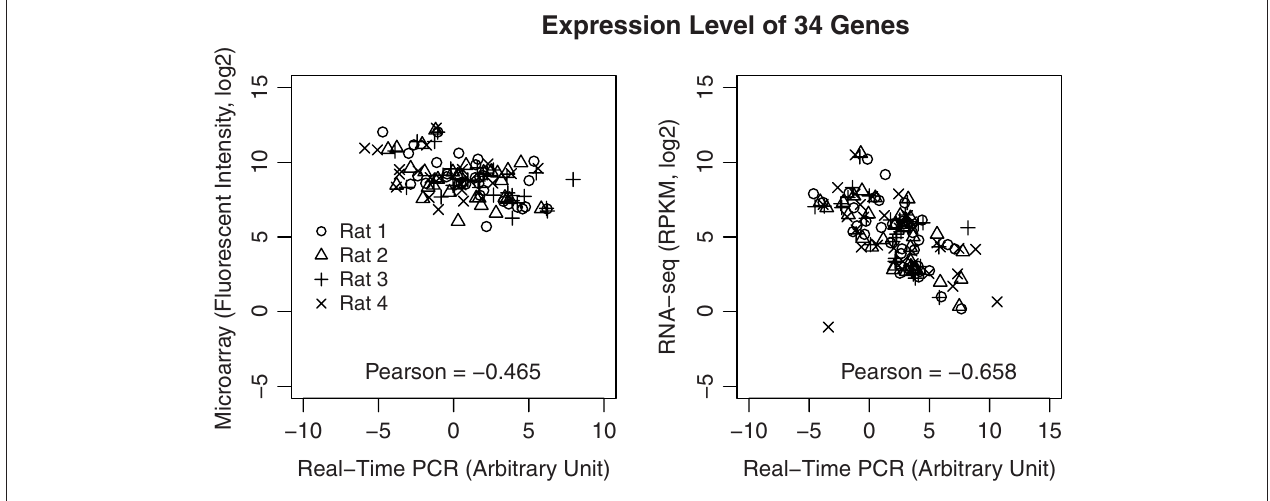
FiGuRe 9 | Validation of gene expression data using real-time PCR. A total of 34 genes were selected across a wide dynamic range. Real-time PCR was performed using the amplified cDNA from each of the microarray and RNA-seq samples. The correlations of the expression levels of these genes measured